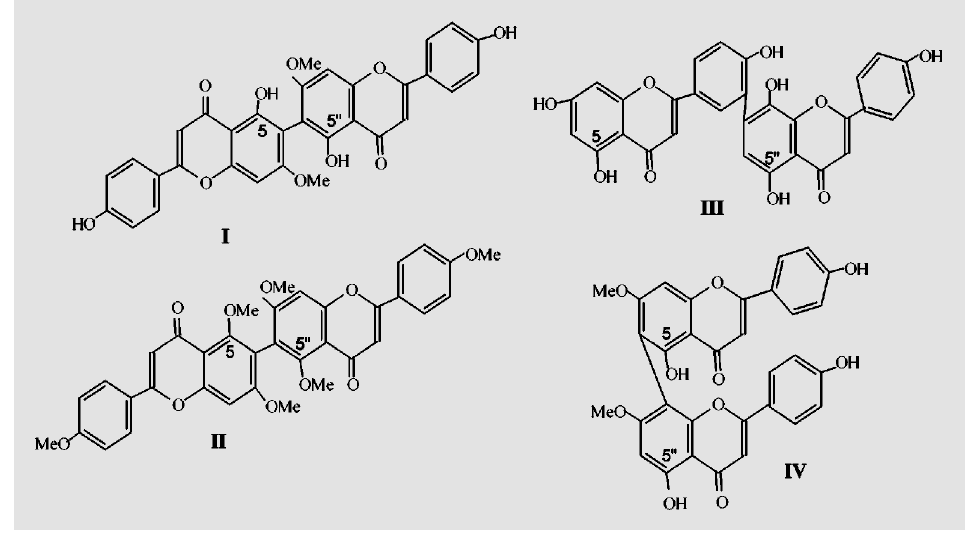
Figure 1. Chemical structure of four biflavonoids: 6,6"-bigenkwa- nin (I), tetradimethoxybigenkwa- nin (II), amenthoflavone (III) and 7,7"-dimethoxyagastisflavone (IV) isolated from Ouratea species, and tested here in cultures of As- pergillus flavus